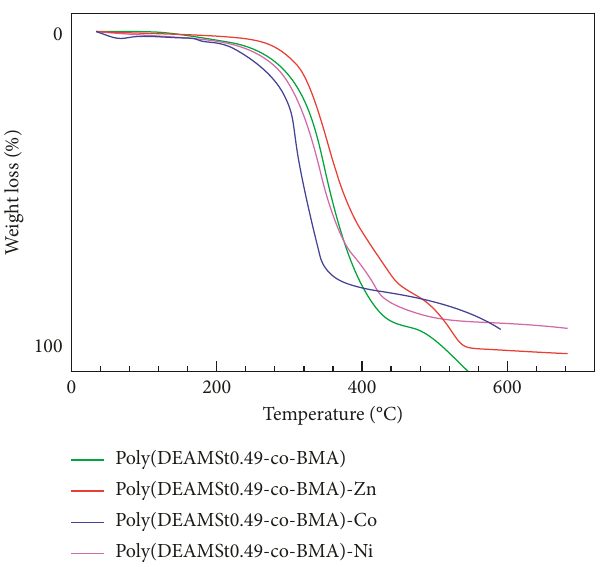
Figure 10: TGA thermograms of poly(DEAMSt0.49-co-BMA), poly(DEAMSt0.49-co-BMA)-Co, poly(DEAMSt0.49-co-BMA)-Ni, and